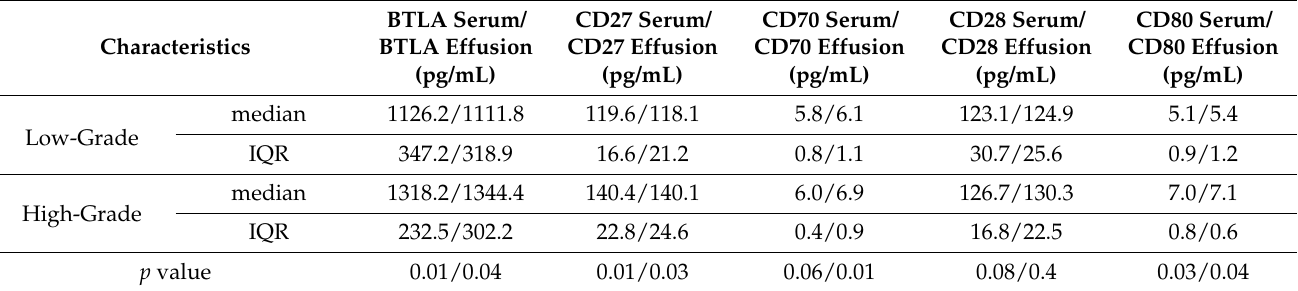
Table 5. Levels of serum and peritoneal fluid concentrations of the studied proteins in the compared grading groups.